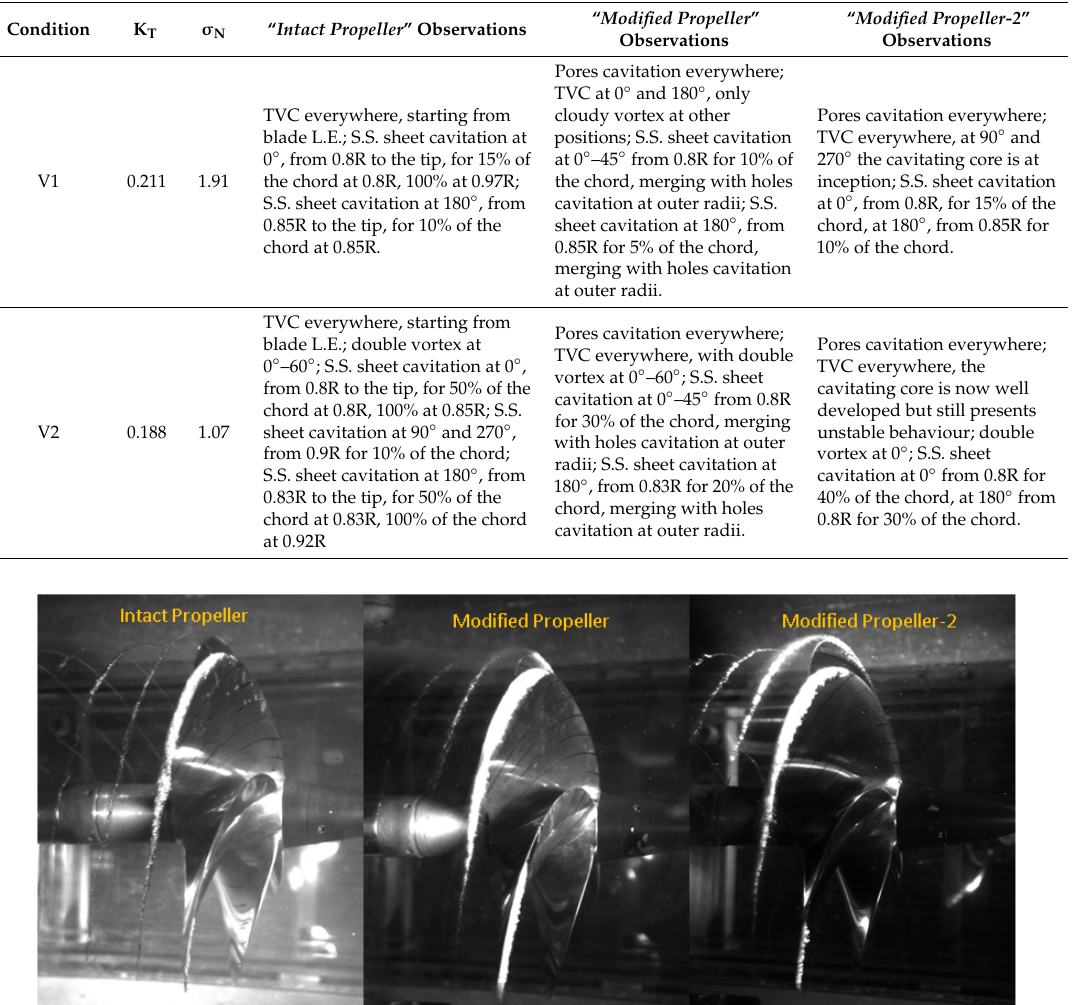
Table 4. Cavitation observation for the intact propeller, Modified Propeller and Modified Propeller-2 cases for Condition V1 and V2.